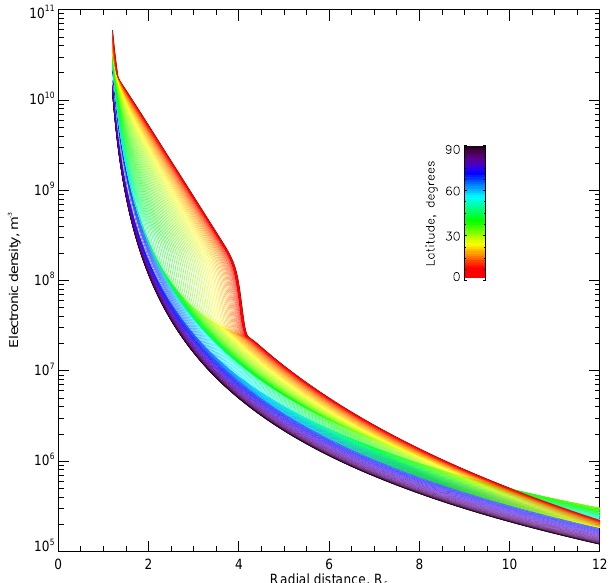
Fig. 1. Electron density as a function of radial distance in R E , show- ing the plasmapause density gradient for different latitudes, from equatorial plane (red), to 90 ◦ latitude (dark blue). Date is 7 Septem- ber 2002, time 00:30UT, and parameters are here MLT = 09:00, K p =